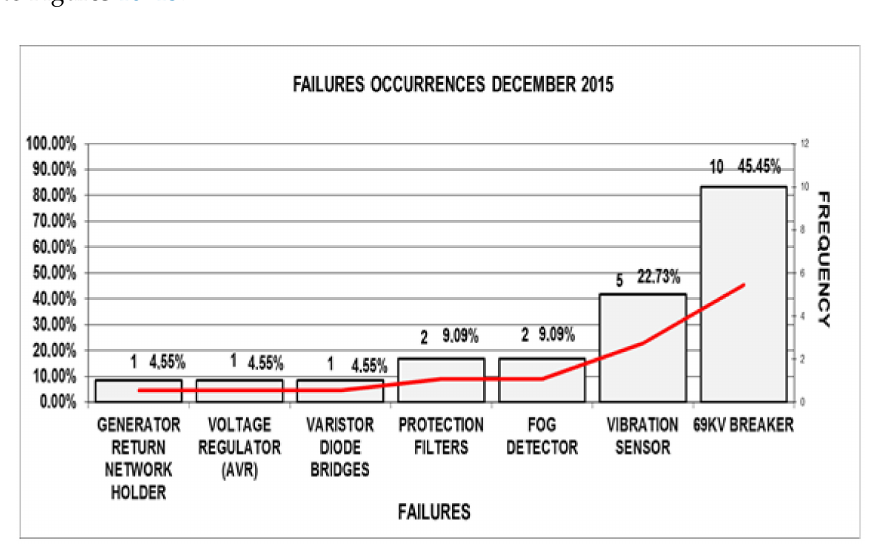
Figure 10. Failure occurrences, December 2015.